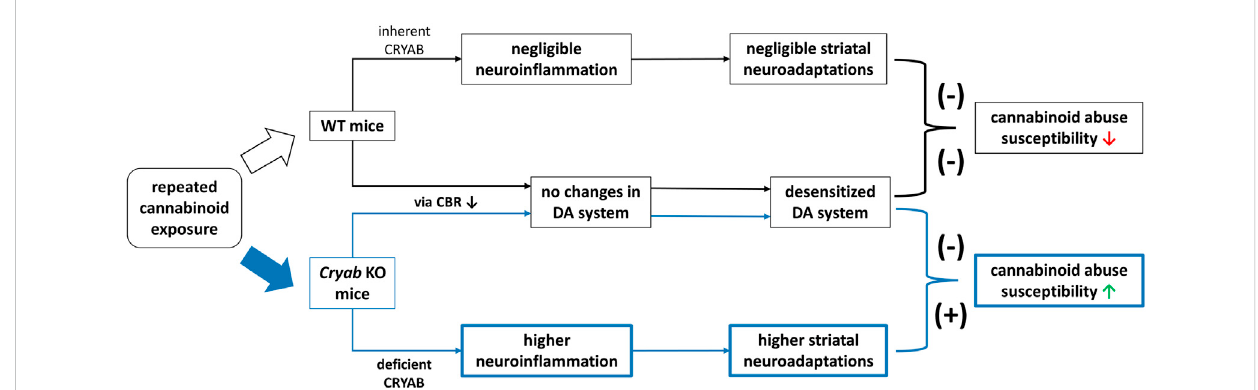
FIGURE 8 Schematic diagram for a proposed mechanism underlying the enhanced JWH-018 abuse susceptibility of Cryab knockout (KO) mice. Repeated administration of cannabinoids, such JWH-018, may result to a reduction in cannabinoid receptor (CBR) expression, leading to a desensitized dopamine (DA) system in both Cryab KO and wild-type (WT) mice. Due to CRYAB de fi ciency, repeated JWH-018 administration resulted in higher striatal neuroin fl ammation, leading to higher neuroadaptations. These changes may potentially contribute to the abuse susceptibility of Cryab KO mice to